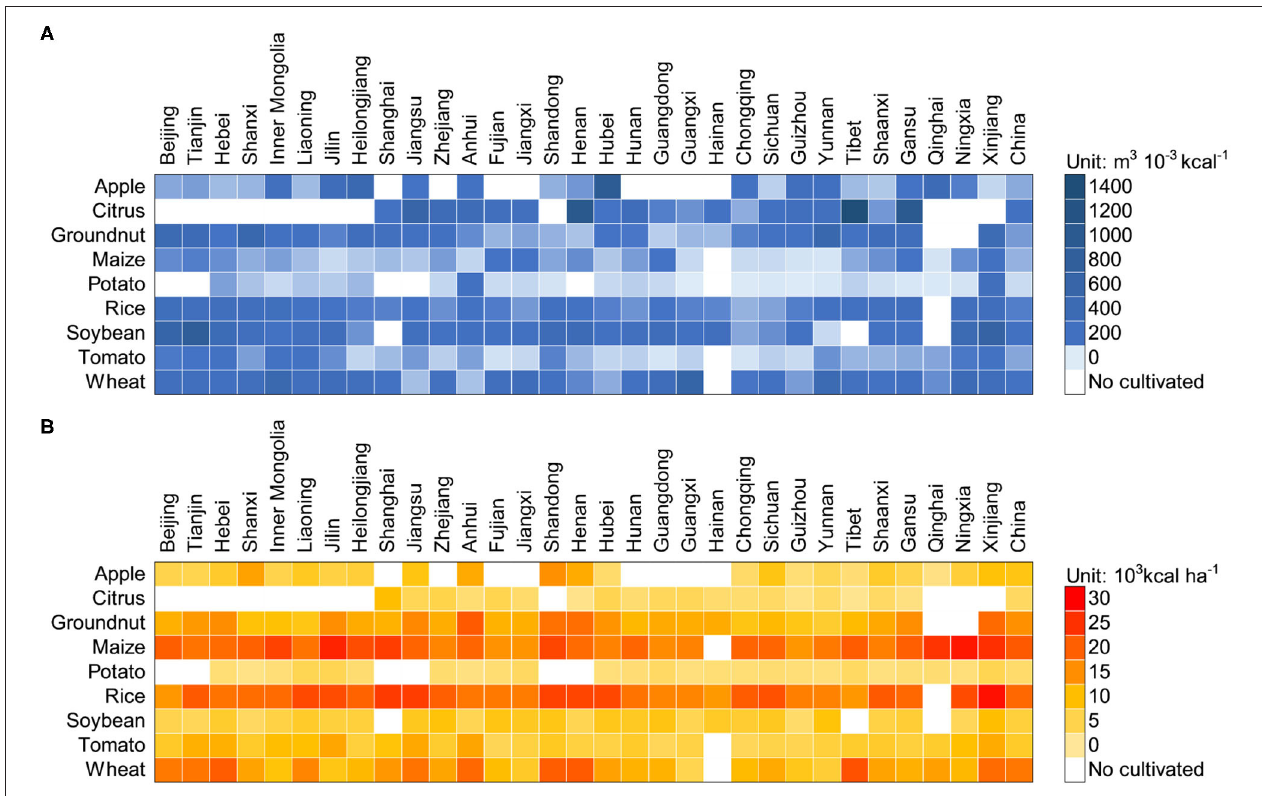
FIGURE 4 | Spatial difference of BWF per unit of calorie production ( ucBWF ) and CP per unit area ( YC ) of crops. (A,B) reveal the BWF per unit of calorie production and the CP per unit area of different crops planted in different regions,